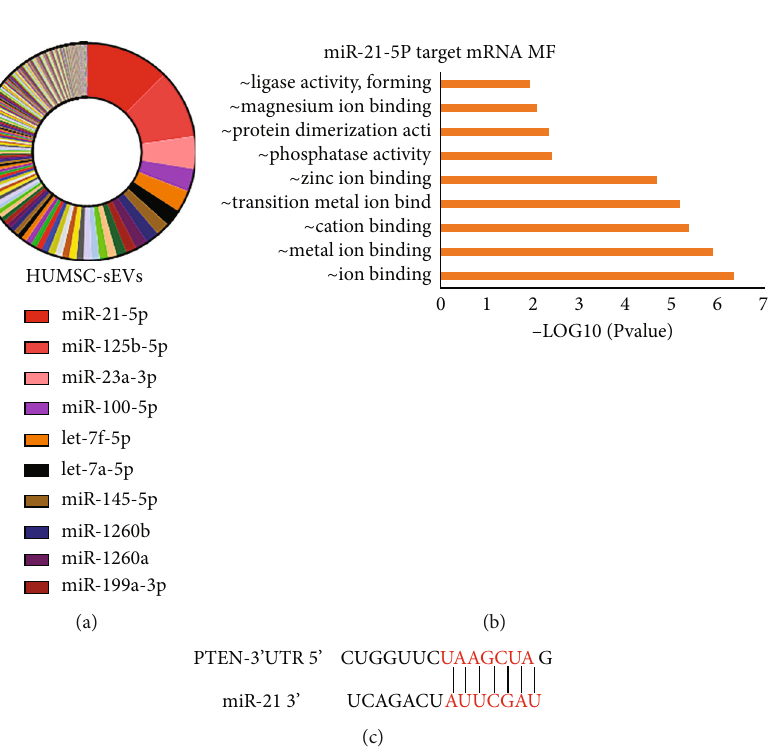
Figure 5: Identi fi cation of miRNAs contained in HUMSC-sEVs. (a) miRNA abundance analysis of HUMSC-sEVs. (b) mRNA targets for the miRNAs signi fi cantly enriched in HUMSC-sEVs were identi fi ed and GO analysis. (c) The binding site between miR-21 and PTEN mRNA. MF: molecular function; GO: gene